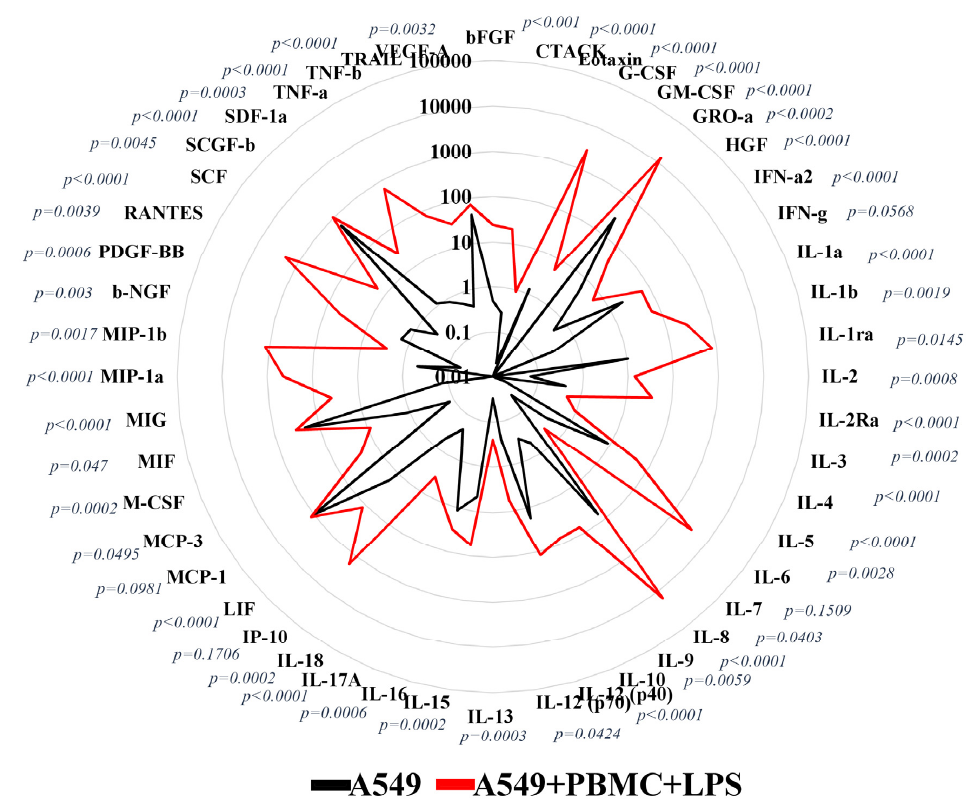
Figure 3. Spider plot, cytokine/chemokine concentrations (pg/mL; log scale) in conditioned medium 24 h after A549 cocultivation with PBMC primed with LPS; n = 5, Unpaired t -test with Welch’s correction.